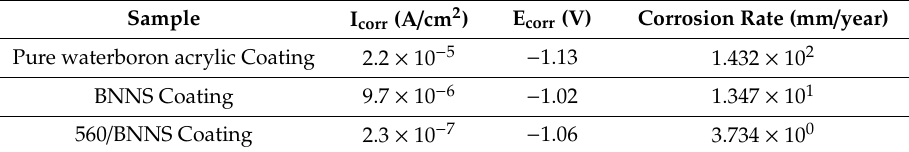
Table 1. Potentiodynamic polarization parameters and corrosion rate calculation results.